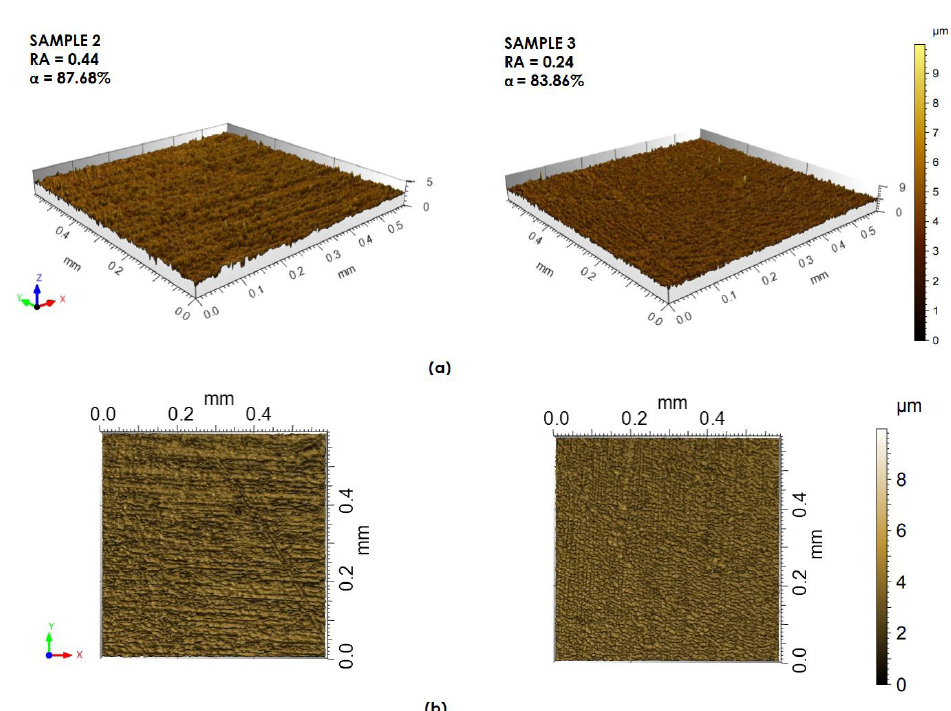
Figure 4. Samples profilometry. Perspective view (a) and top view